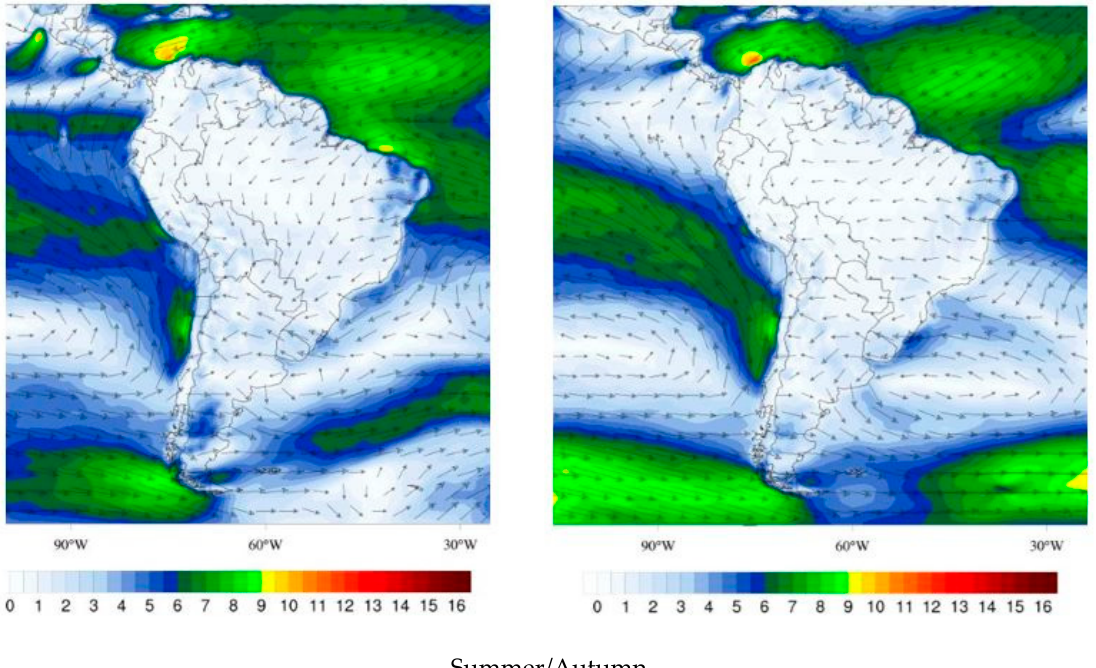
Figure 5. Map of the South Atlantic Ocean winds at 10 m, units in m/s. Referring to the Parnaíba/Fortaleza System. Source: [50].